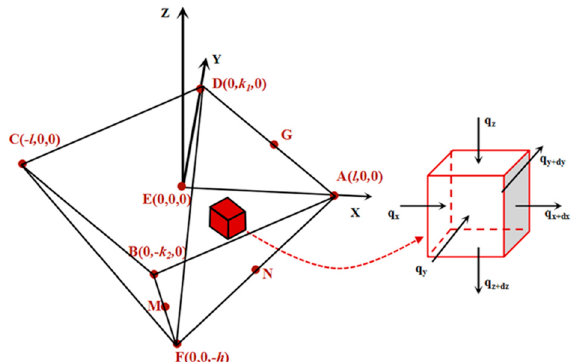
Figure 5. Simplified 3D model of the temperature field in the pyramid nano/microscale air gap is shown on the left side. The coordinate system is located at the initial contact point. Points A, B, C, and D are the vertex of the surface contour; point E is the position of tip peak approximate coincidence with the origin; point F is the vertices of inverted pyramid air gap structure; points G, M, and N are certain points on their own pyramid edge. The red cube is a heat conduction element at any position inside the temperature field. The thermal equilibrium analysis of the heat conduction element is shown on the right side.